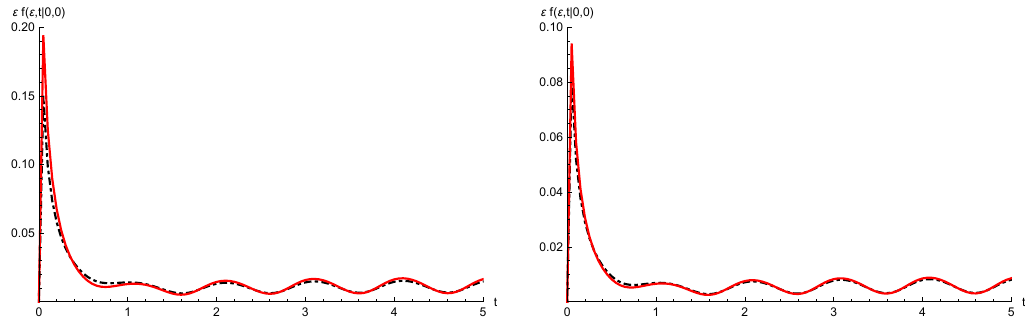
Figure 7. For the same choices of parameters of Figure 6, the function ε f ( − ε , t | 0,0 ) (red curve) is compared with the probability p 0, − 1 ( t | 0 ) (black dashed curve) for ε = 0.05 (left) and ε = 0.025 (right).